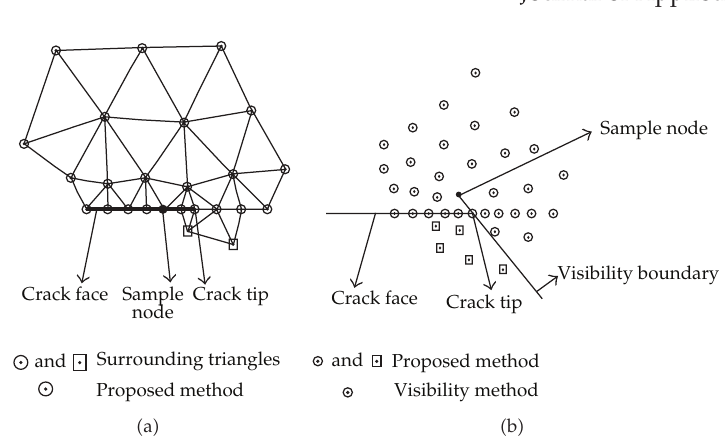
Figure 2: (cid:2) a (cid:3) Comparison between surrounding triangles method and the proposed method (cid:2) b (cid:3) Compari- son between visibility method and the proposed method.